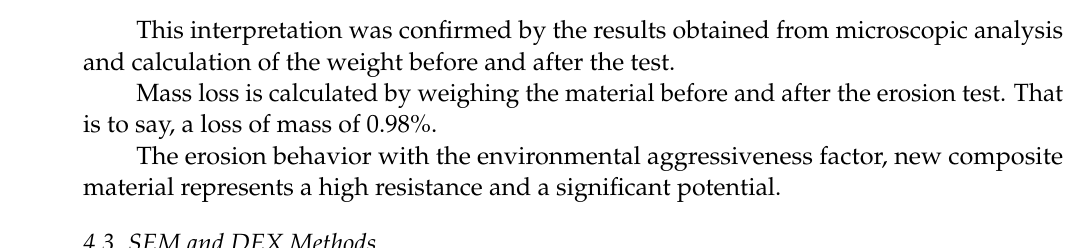
Figure 6. Micrographs of sample before test ( a ) and after test in the polluted phosphoric acid with particles abrasives SiC ( b